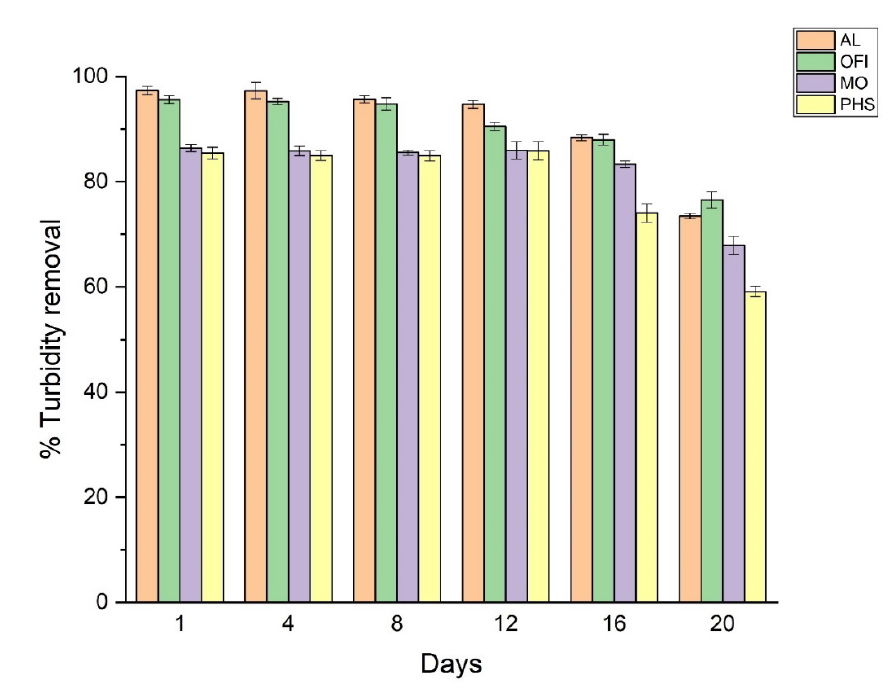
Figure 7. Effect of bio-coagulants aging on turbidity removal. Figure 7 . Effect of bio-coagulants aging on turbidity removal.